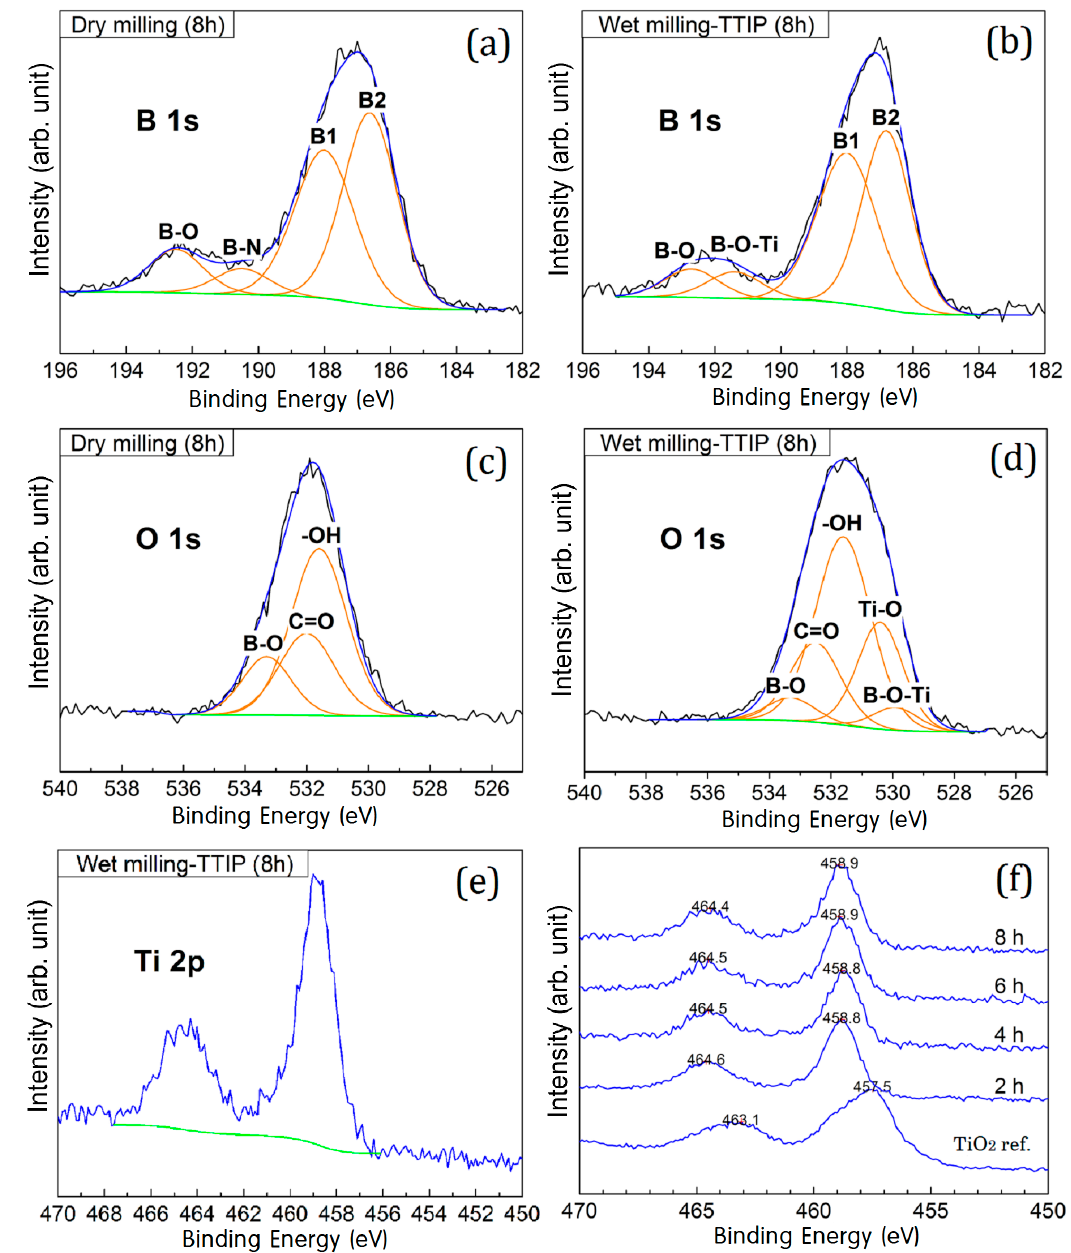
Figure 5. High-resolution narrow scan X-ray photoelectron spectra (XPS): ( a ) B 1s spectrum of the 8 h dry milled boron sample; ( b ) B 1s spectrum of the 8 h wet milled boron sample; ( c ) O 1s spectrum of the 8 h dry milled boron sample; ( d ) O 1s spectrum of the 8 h wet milled boron sample; ( e ) Ti 2p spectrum of the 8 h wet milled boron sample; and ( f ) Ti 2p spectra of the pure TiO 2 (rutile phase) for 2 h, 4 h, 6 h, and 8 h wet milled boron samples.